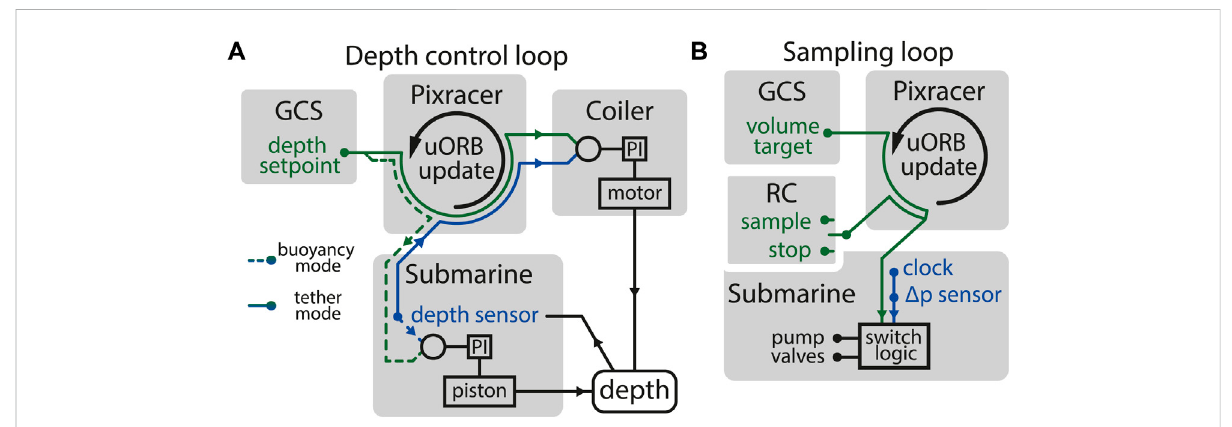
FIGURE 5 Distribution of actuators, sensors, control logic and user interfaces used across the MEDUSA system for: (A) μ UV depth control and (B) sample collection